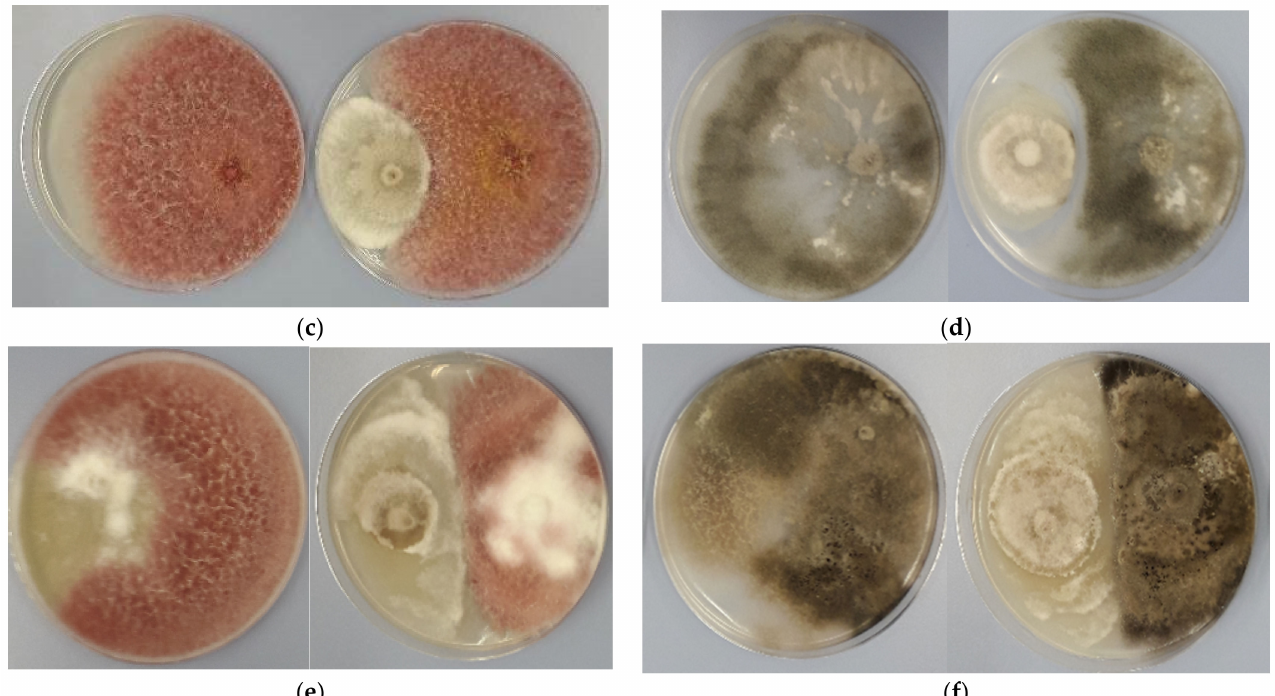
Figure 3. Dual culture assay between endophytic Diaporthe against 6 plant pathogens ( a – f ): ( a ) on the left— T. roseum as a control, on the right —D. eres (endophyte) with T. roseum ; ( b ) on the left— V. dahliae as a control, on the right— D. eres (endophyte) with V. dahliae ; ( c ) on the left— F. sporotrichioides as a control, on the right— D. eres (endophyte) with F. sporotrichioides ; ( d ) on the left— B. cinerea as a control, on the right— D. eres (endophyte) with B. cinerea ; ( e ) on the left— F. avenaceum as a control, on the right— D. eres (endophyte) with F. avenaceum ; ( f ) on the left— A. alternata as a control, on the right— D. eres (endophyte) with A. alternata ; (photo by B.